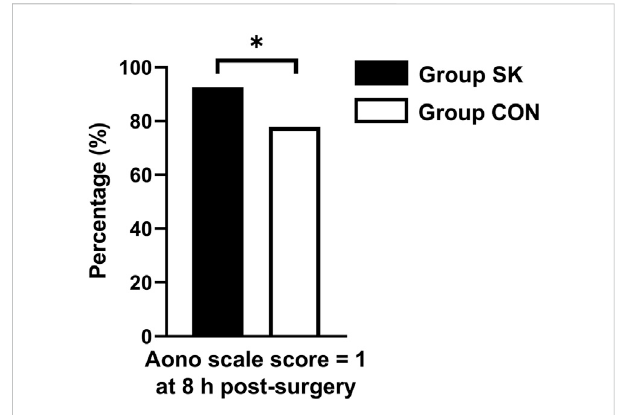
FIGURE 3 Distributions of patients with Aono scale = 1 at 8 h postoperatively. * p < 0.05 when compared with the control group. Group SK, the S-ketamine group; Group CON, the control